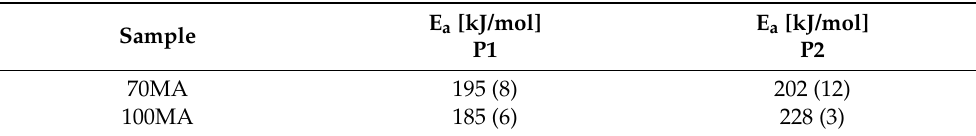
Table 2. The activation energies of the processes, P1 and P2, observed in DSC non-isothermal heating curves. Calculation based on Kissinger